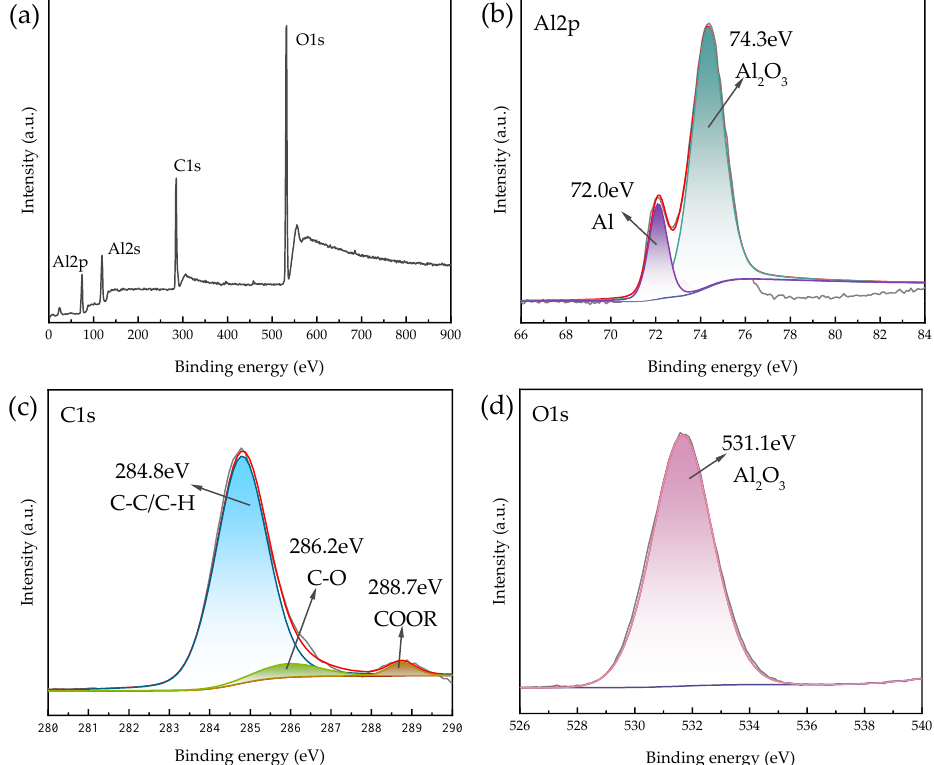
Figure 4. XPS spectra of C 8 H 18 -Al nanoparticles: ( a ) XPS full-scan spectrum, ( b ) Al2p, ( c ) C1s, and ( d )